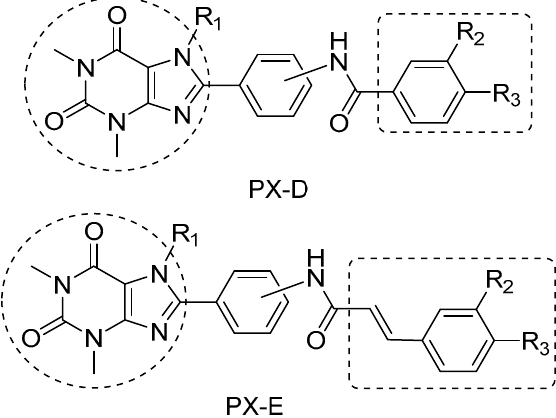
Figure 2. Parent nucleus for the target compounds of the PX-D and PX-E series.